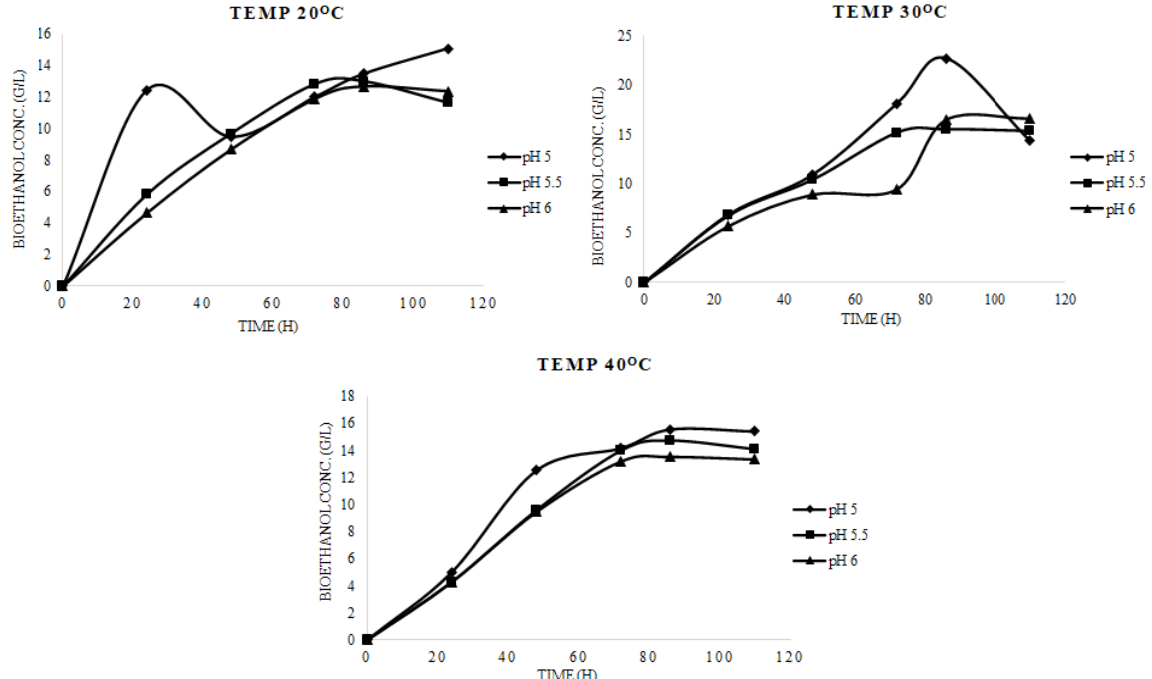
Figure 8. Effect of time, temperature, and pH on bioethanol production using co-culture strain.